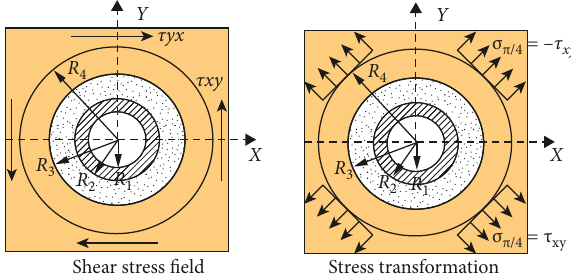
Figure 11: Stress distribution induced by shear stress.